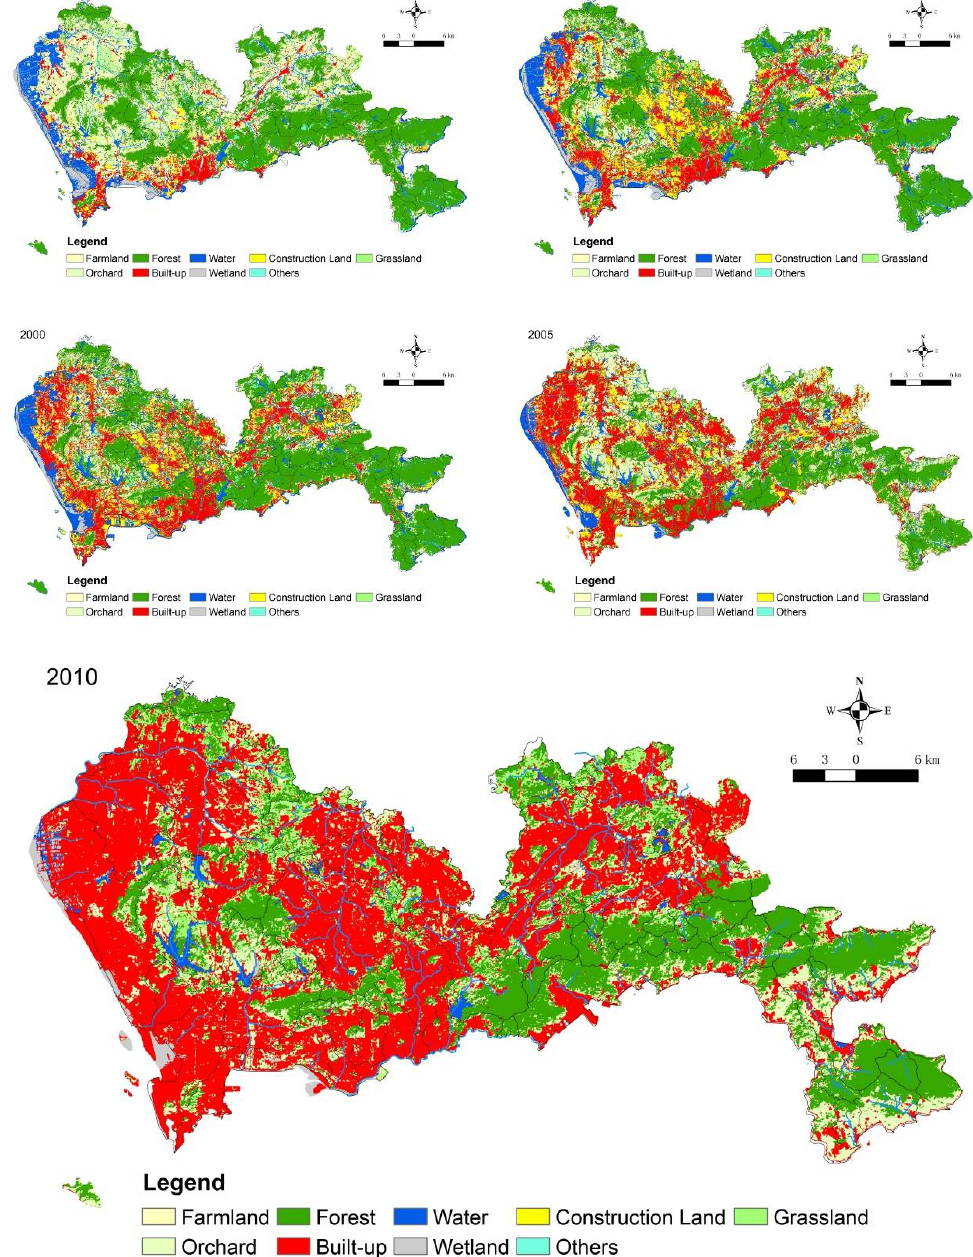
Figure 2. Landscape distributions in Shenzhen during 1990–2010.